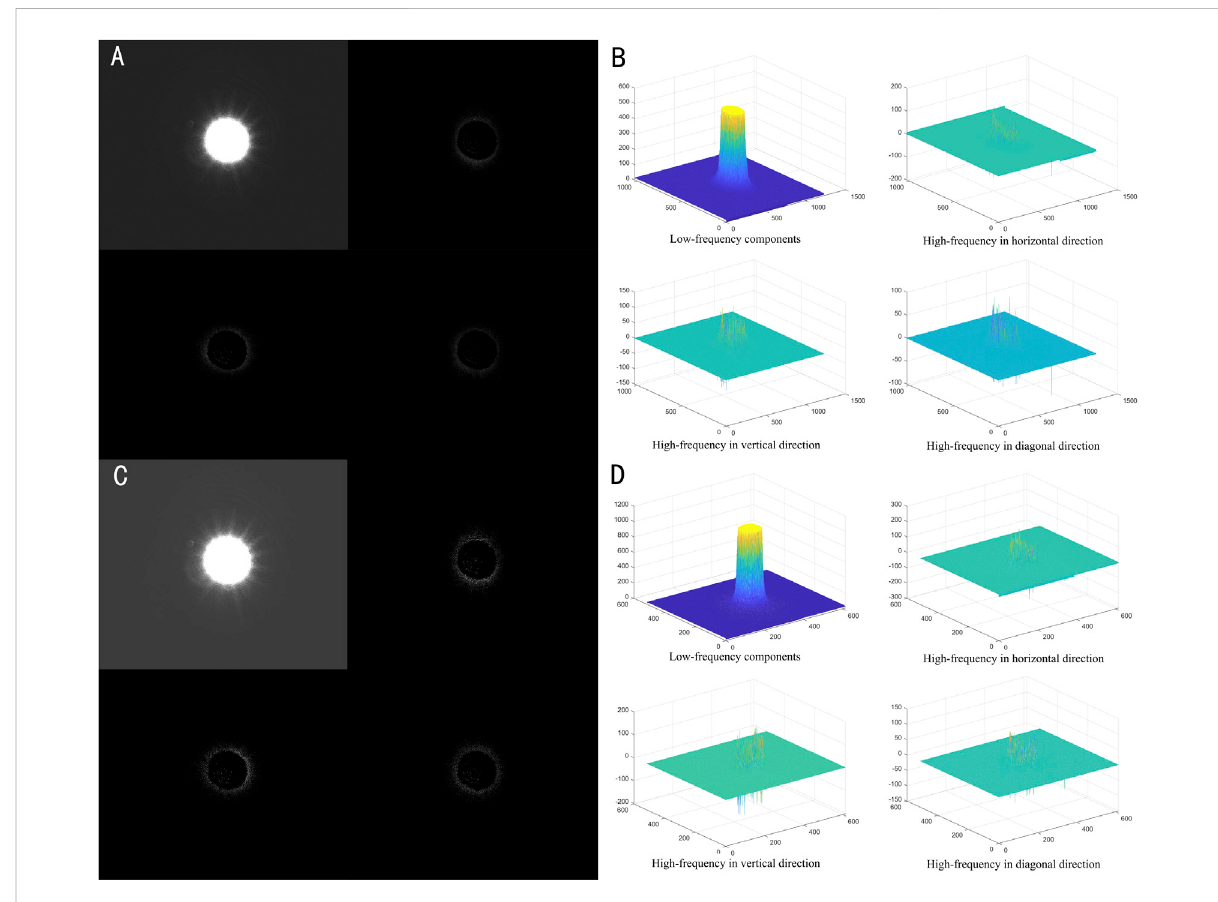
FIGURE 2 WaveletDecompositionResultsandWaveletCoef fi cientDistribution ofLaserSpotImage. (A) :The fi rstlayerofwaveletdecomposition; (B) :The fi rst layer of wavelet coef fi cient distribution; (C) : The second layer of wavelet decomposition; (D) : The second layer of wavelet coef fi cient